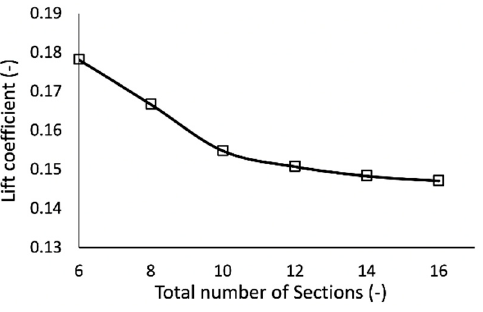
Figure 4. Parametric studies for the determination of the required number of sections.